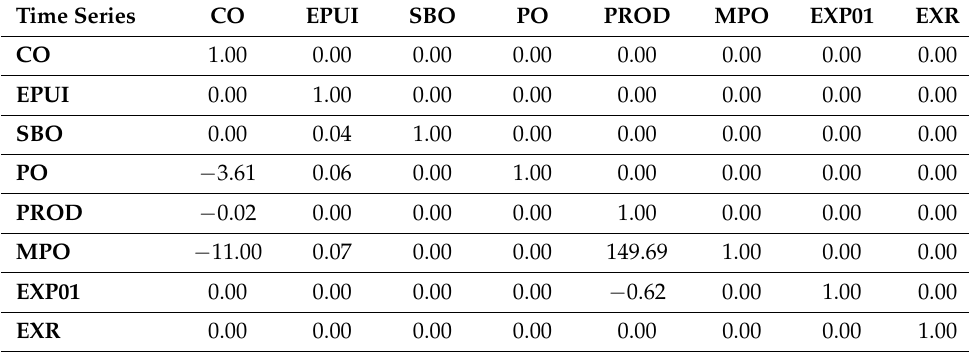
Table 13. Structural matrix A after replacing IDVT with